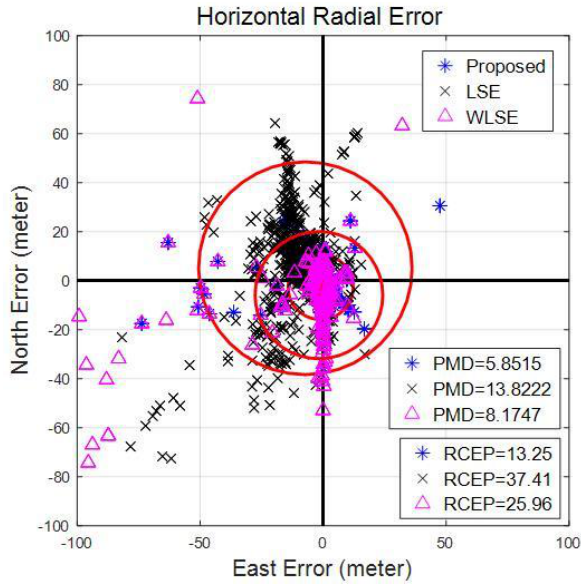
Figure 9. HRE of proposed estimator against LSE and WLSE.